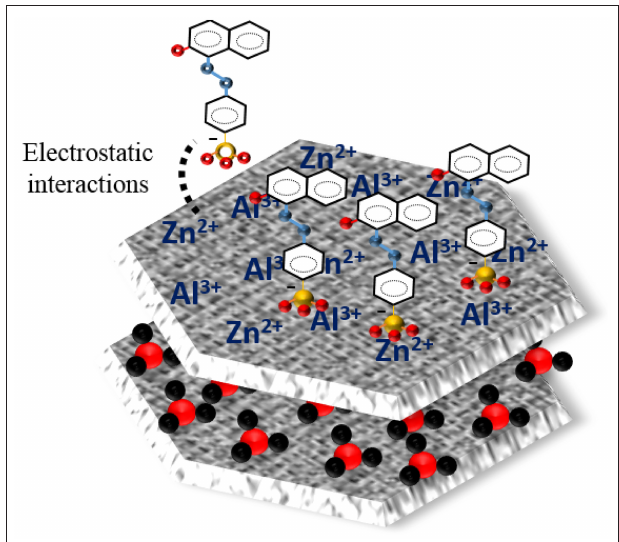
FIGURE 12 | Schematic representation on Orange II adsorption onto surface of